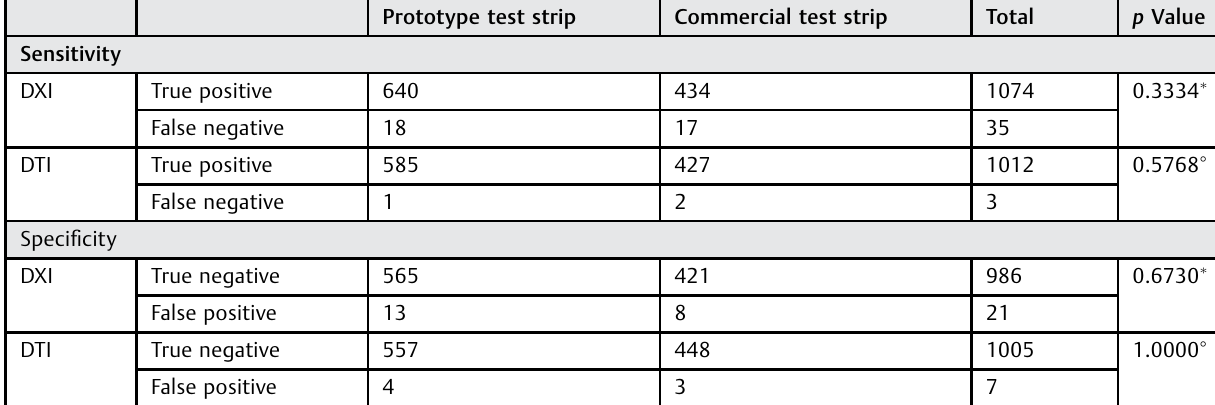
Table 5 Sensitivity and speci fi city data: Frequencies ofcorrect positive, correct negative, false positive and false negative results by pooled data using prototype and commercial test strips to detect DXI and DTI